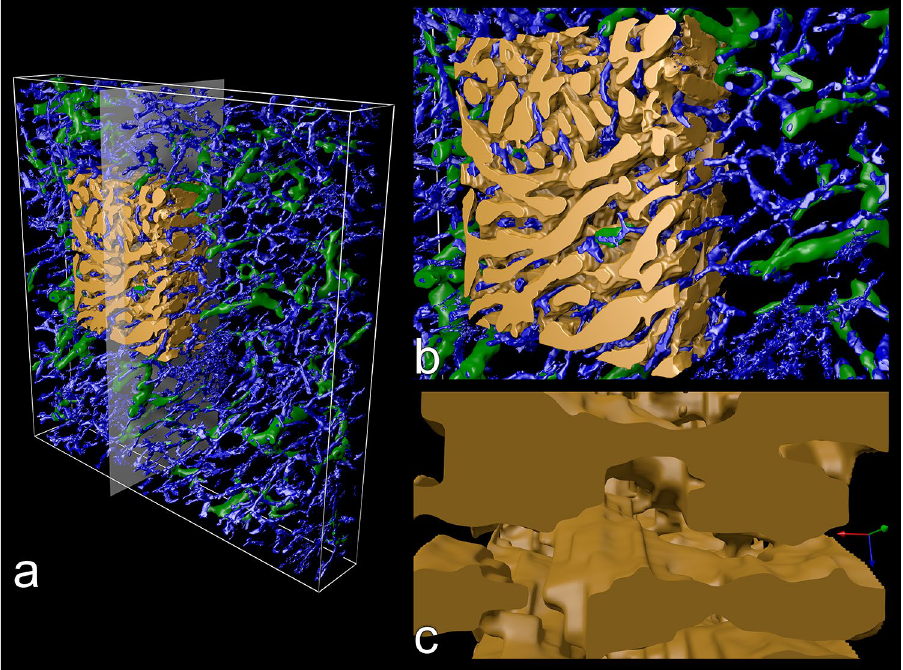
Figure 7. Detailed 3D model of red pulp sinus network. ( a ) Overview of ROI 3 with CD141 + sinuses (brown) and the CD34 + capillary network (blue) with CD271 + capillary sheaths (green). The sinuses were segmented manually in a part of the ROI by delineating the outermost brown contour of the endothelial cells. The granular blue structures in the right part of the model represent superficial fibroblasts of a trabecula (see Fig. 3e). ( b ) Higher magnifcation of ( a ). ( c ) Further magnified internal structure of the sinus network sectioned in the YZ-plane as indicated in ( a ). The light brown surfaces represent three story-like flat clefts with holes and irregularities extending in the XZ-plane and seen from above. The round structure in the upper part of the model is of single cell size. Four of these unknown structures are present in the model. Green arrow: X-axis; blue arrow: Y-axis; red arrow: Z-axis. Side of bounding box in ( a ) = 1